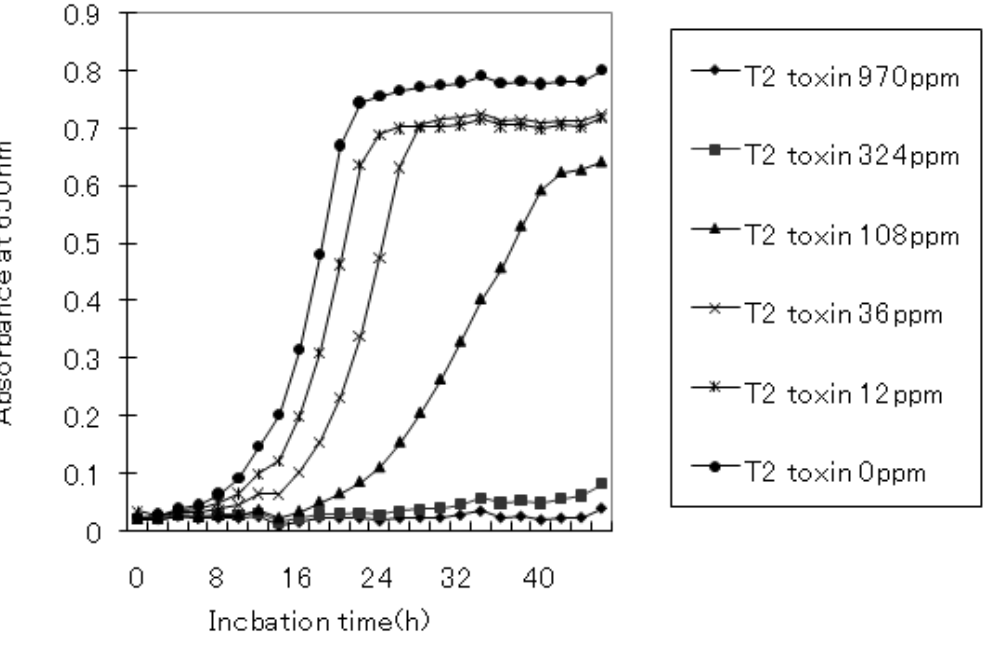
Figure 1. Effect of T-2 toxin on yeast growth. Varying amounts of T-2 toxin, dissolved in DMSO at concentration of 2,000 ppm, were added to YPD medium at the indicated